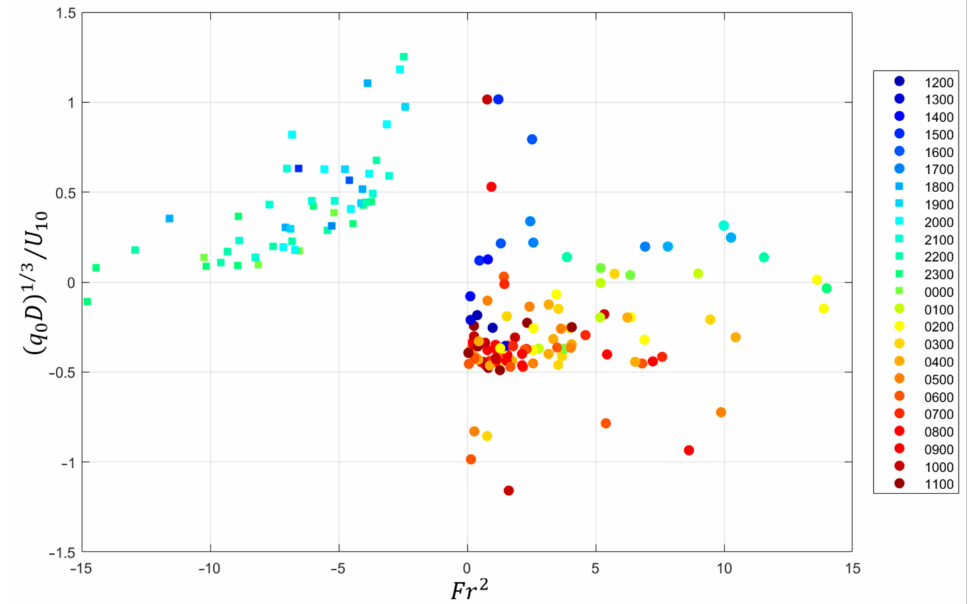
Figure 15. All WRF runs: Fr 2 vs. ( q 0 D ) 1/3 / U 10 .